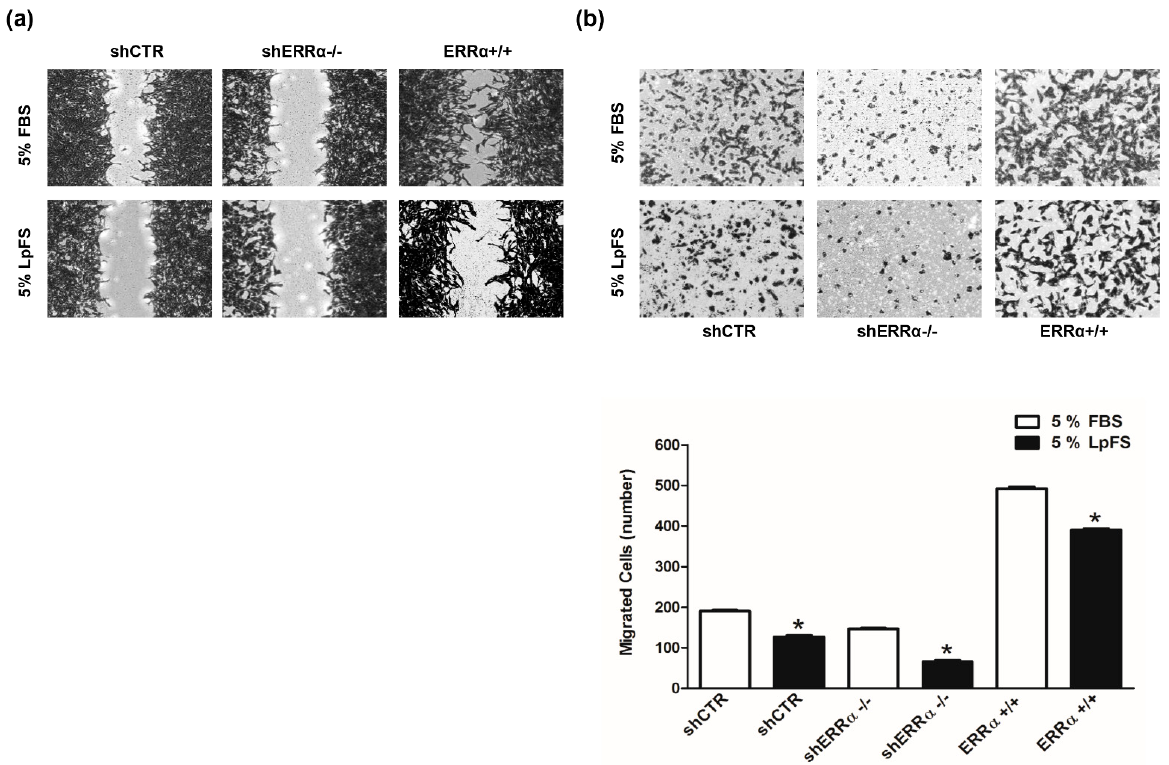
Figure 9. ERR α expression levels and cholesterol influence H295R cell migration. ( a ) H295R clones (shCTR, ERR α +/+, shERR α − / − ) were maintained in 5% FBS or 5% LpFS containing medium. Cells were used in Wound Healing ( a ) and Boyden Chamber ( b ) assays performed as reported in “Materials and Methods”. ( a ) Images are from a representative experiment (100× magnification). ( b ) Migrated cells were photographed under an inverted microscope (20× magnification) and counted with ImageJ software. Graphs represent the mean ±SD of three independent experiments (* p < 0.05 vs. FBS).